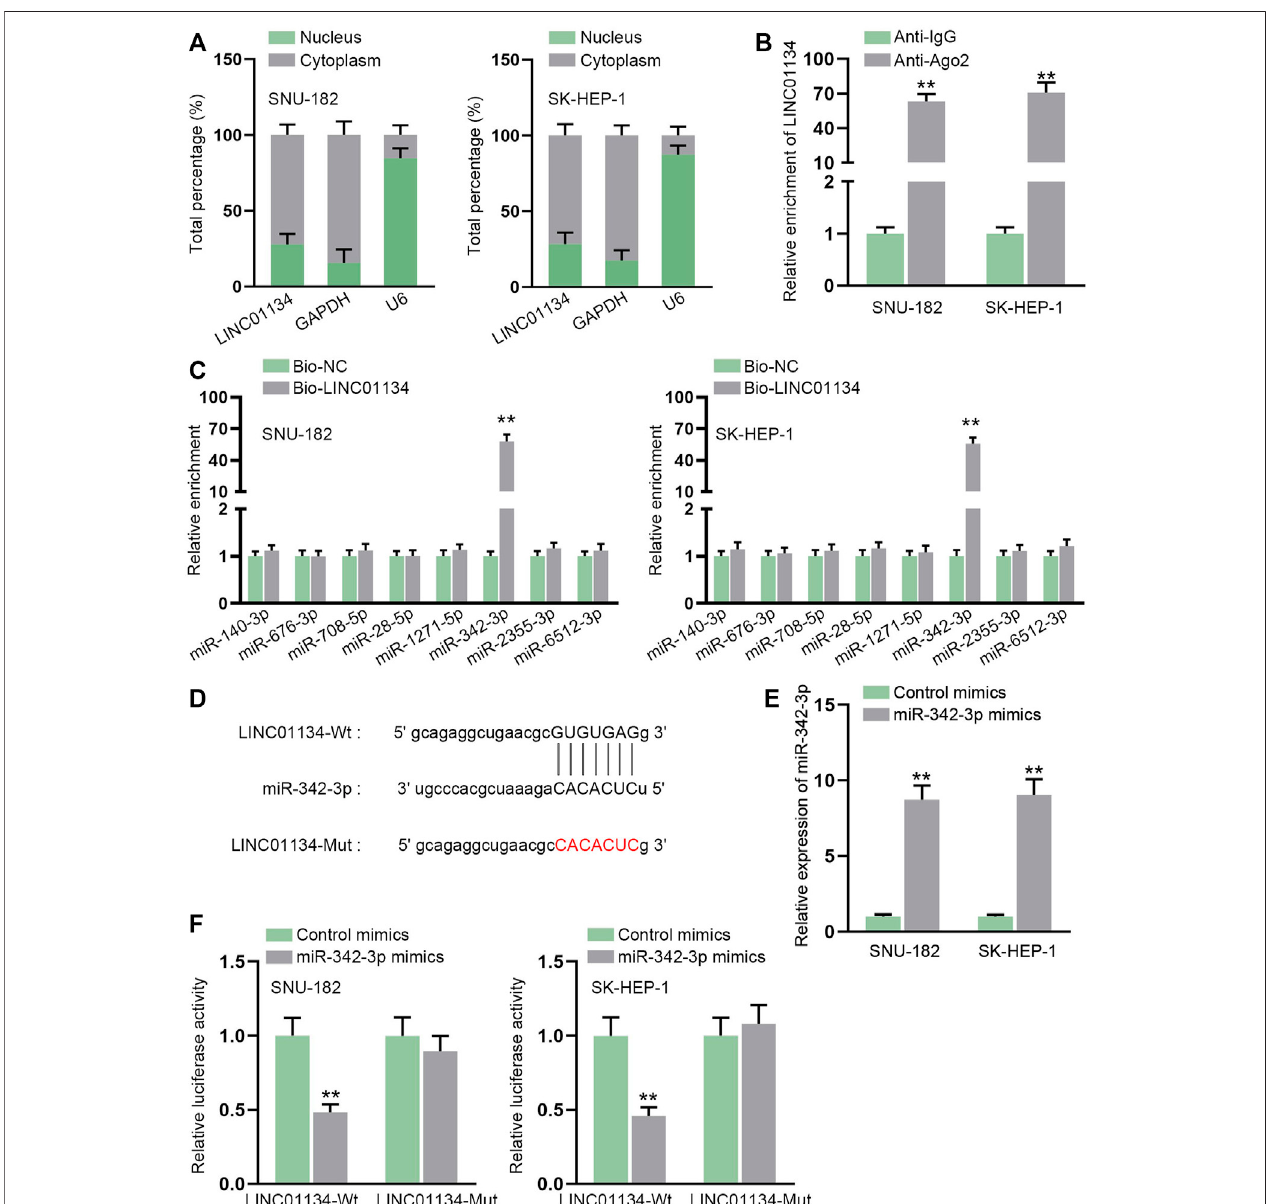
FIGURE 4 | LINC01134 serves as a sponge for miR-342-3p. (A) Subcellular fractionation assay was implemented to ascertain the location of LINC01134 in HCC cells. (B) RIP assay was done to verify the interaction between LINC01134 and Ago2 protein. (C) RNA pull-down assay was employed to detect the enrichment of predictedeight miRNAsinthebiotin-labeledLINC01134probe. (D) StarBasewasemployed toprojectthebindingsequencebetweenLINC01134andmiR-342-3p. (E) The overexpression ef fi ciency of miR-342-3p mimics was examined by RT-qPCR in HCC cells. (F) Luciferase reporter assay was operated to test the luciferase activity in the LINC01134-Wt group and LINC01134-Mut group after transfection of miR-342-3p mimics. ** p < 0.01.